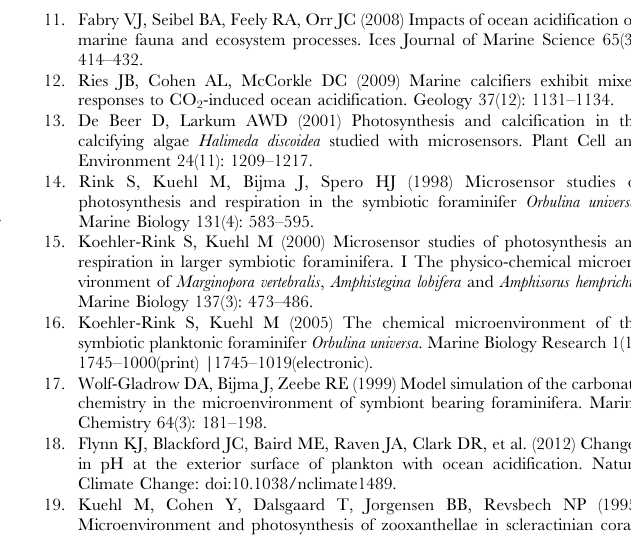
Figure S1 Close up of the six foraminiferal species, photographed via dissecting microscope (A–E) and back- light microscope (F). Images were taken after control (432 m atm) treatment incubations. A) Marginopora vertebralis , B) Amphistegina radiata , C) Heterostegina depressa , D) Peneroplis sp., E) Quinqueloculina sp. and F) Miliola sp. individuals. Sizes are stated as largest possible diameter of individuals.